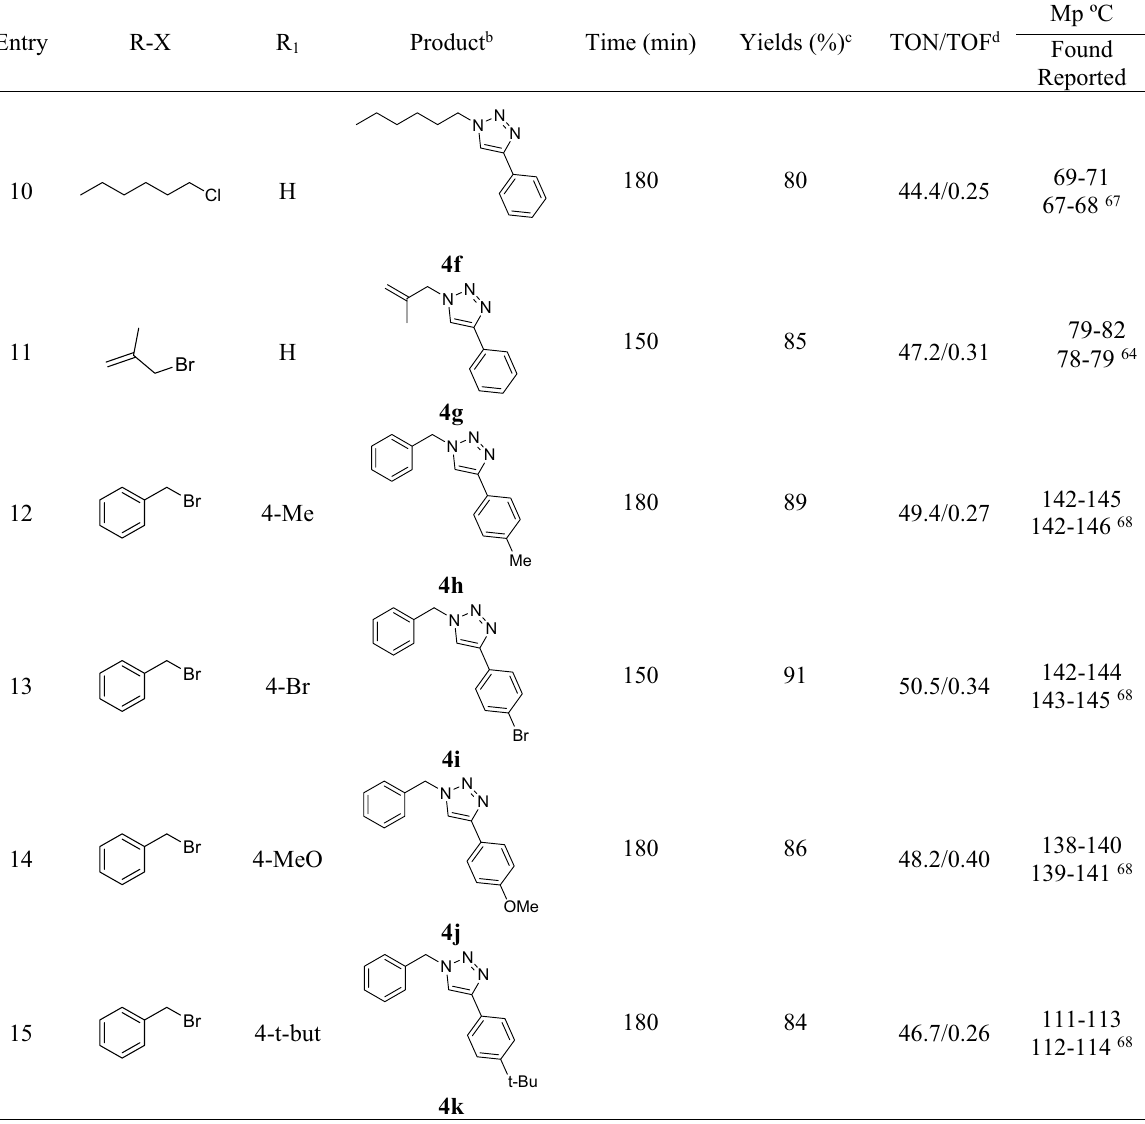
Table 2. Synthesis of 1,2,3-triazole derivetives using Fe 3 O 4 @HKUST-1 nanocatalyst a . a Reaction